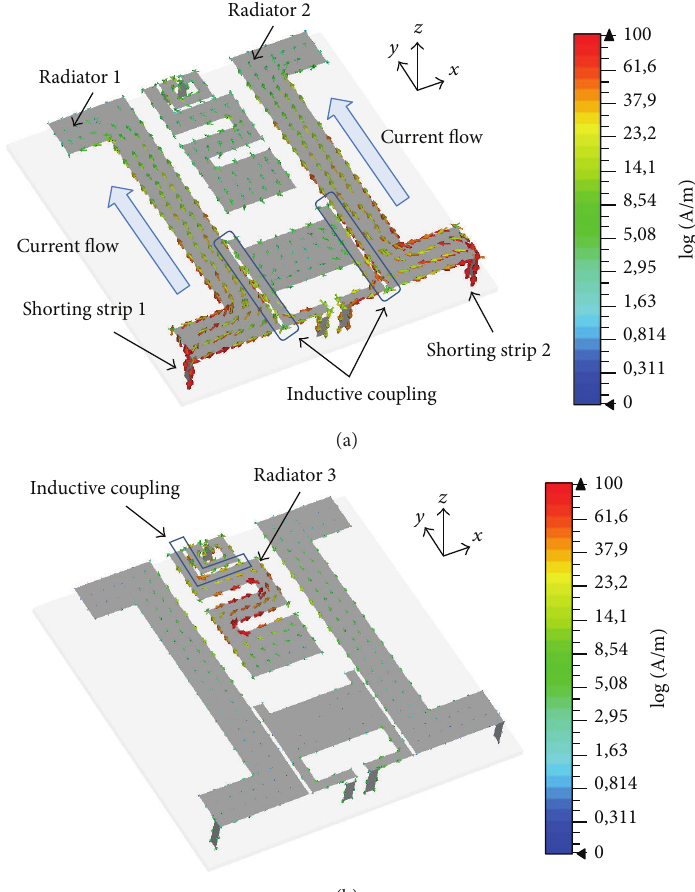
Figure 2: Simulated surface current distributions on the proposed antenna: (a) 920 MHz and (b) 2.425 GHz.